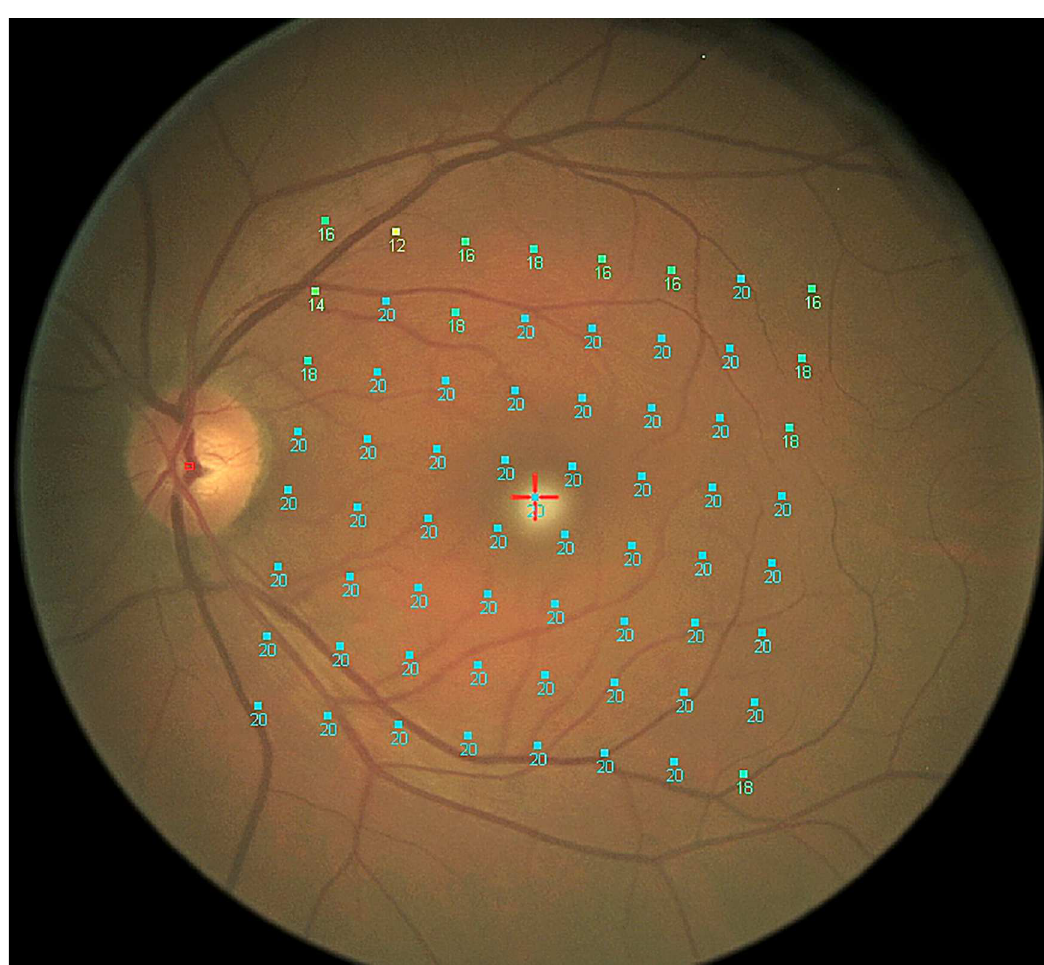
Fig 1. Posterior Pole numeric map of retinal differential light sensitivity of MP1 of a healthy